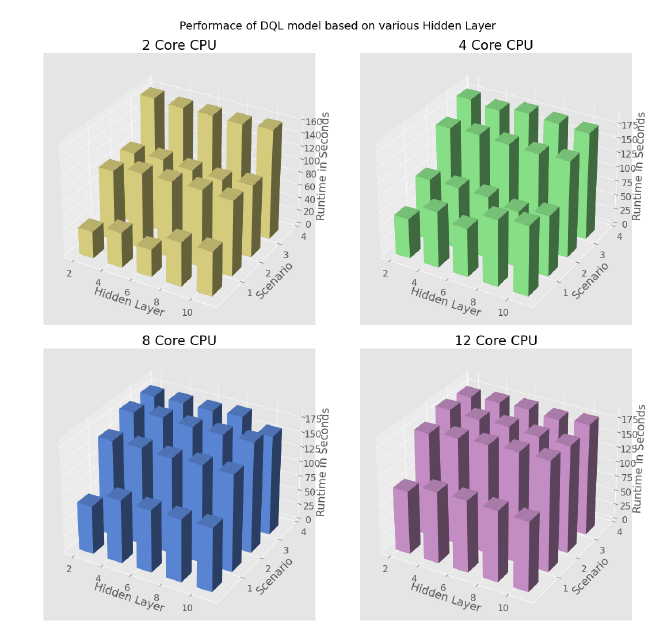
Figure 10. Hidden Layer performance in terms of Runtime.